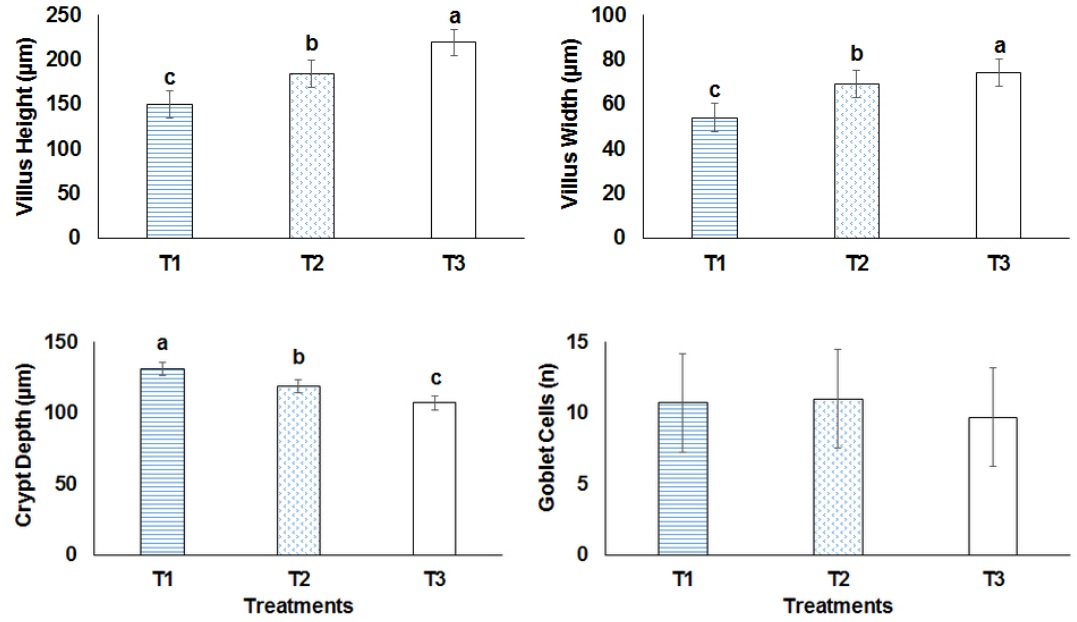
Figure 3. Morphometric analysis of ileum in different treatments. T1: induced colorectal cancer; T2: